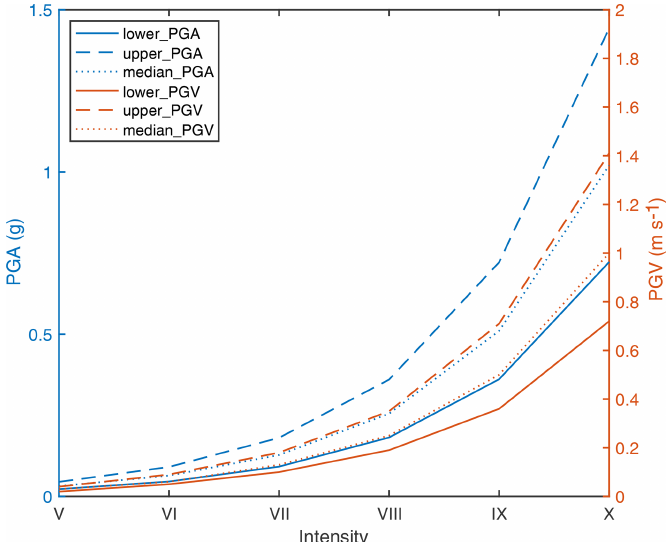
Figure A2. The suggested correspondence relation between intensity and the PGA–PGV range by the Chinese Seismic Intensity Scale (GB/T 17742-2008,